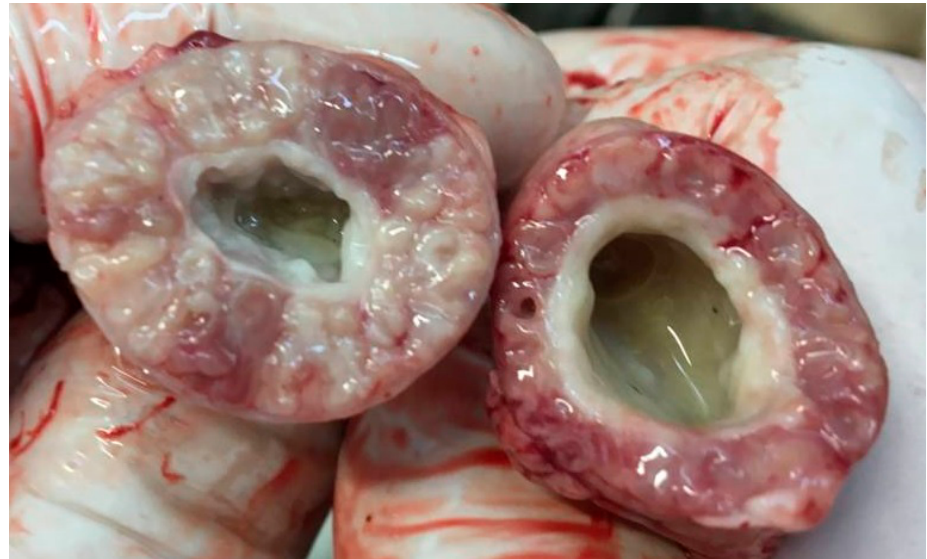
Figure 1. Gross lesions. Proventriculi of TVP (left) and Control (right) broiler chickens examined at 14